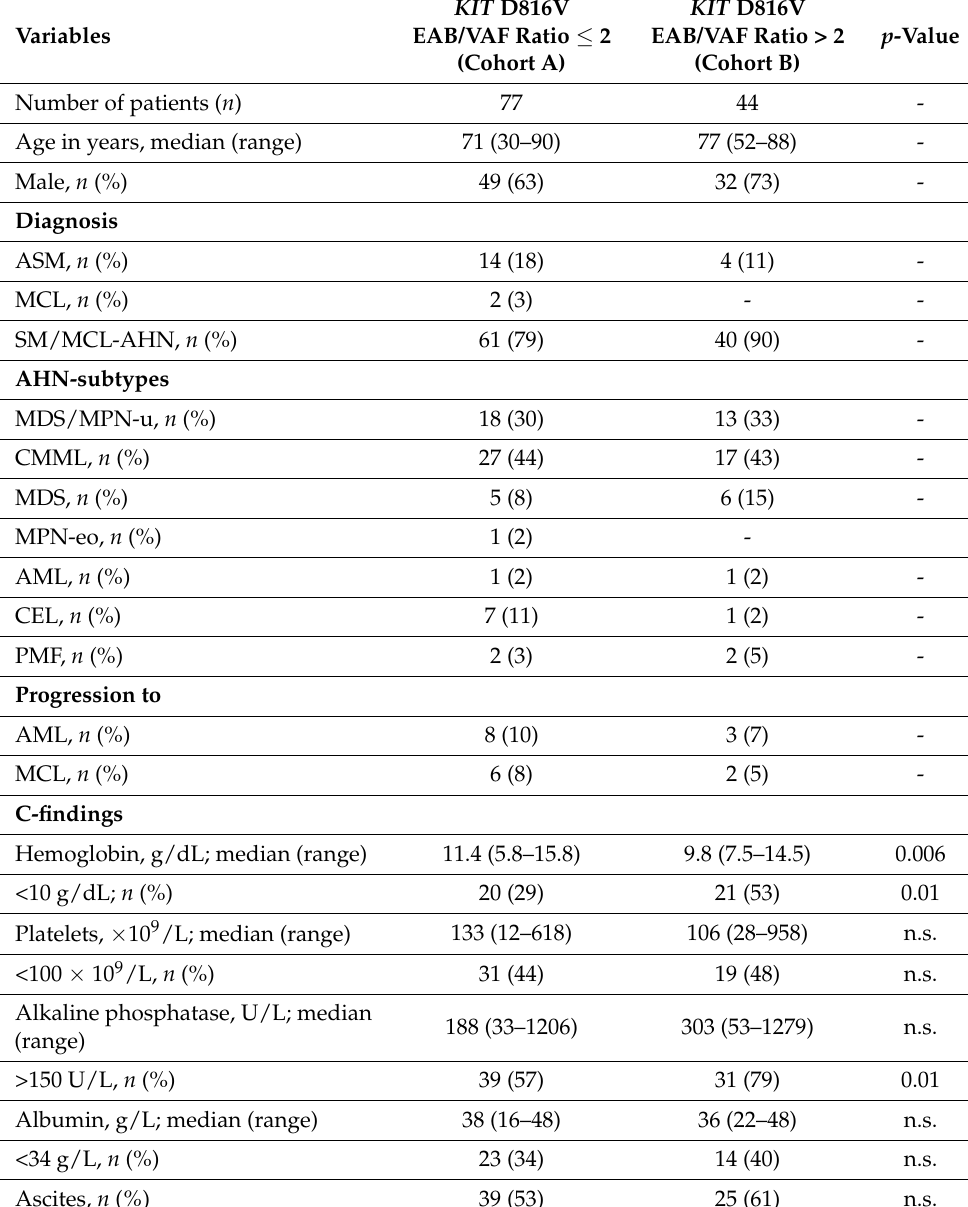
Table 2. Clinical, laboratory, genetic, and outcome characteristics of 121 advanced systemic mastocy- tosis (AdvSM) patients stratified by an expressed allele burden/variant allele frequency ratio of ≤ 2 (cohort A) and > 2 (cohort